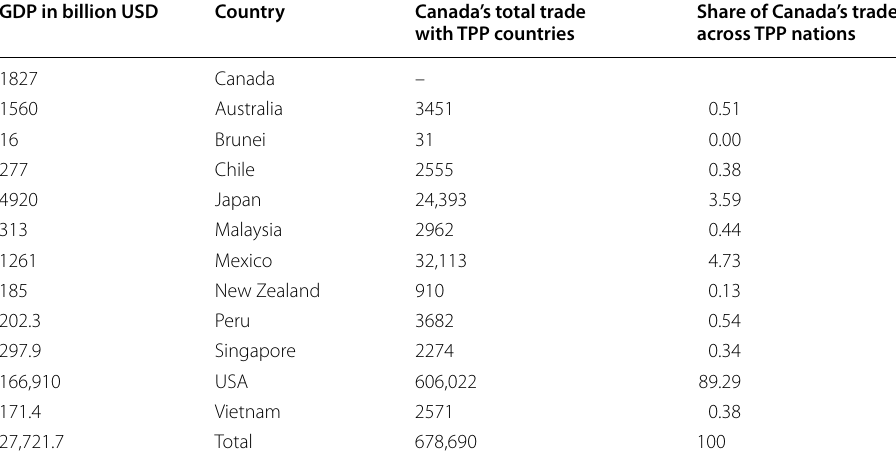
Table 1 GDP of TPP member countries and Canada’s total trade with TPP countries (in mil- lion USD) in 2013. Source : World Bank, Canadian Council of Chief Executives GDP in billion USD Country Canada’s total trade Share of Canada’s trade with TPP countries across TPP